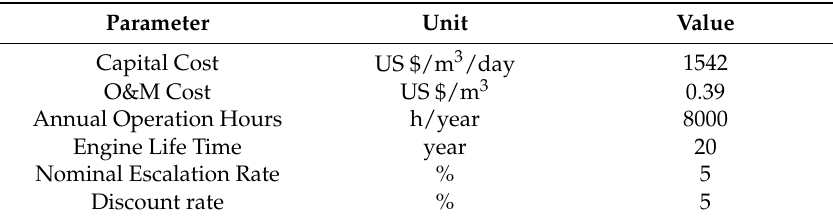
Table 3. Economic Parameters for a 6000 m 3 /day MED-TVC unit